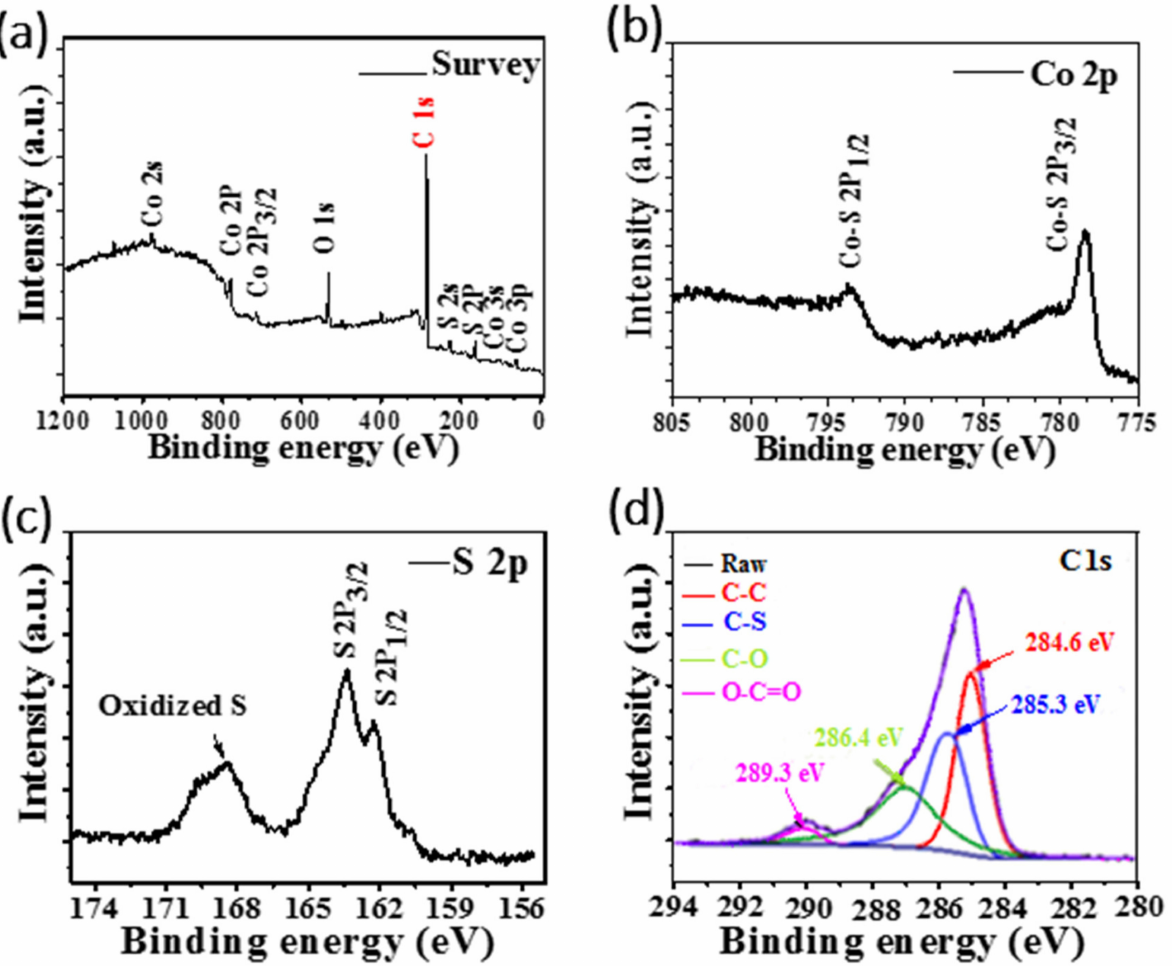
Figure 4. XPS spectrum of CSG composite: ( a ) survey spectrum, ( b ) Co 2p, ( c ) S 2p, and ( d ) C 1s of XPS spectrum of CoS 2